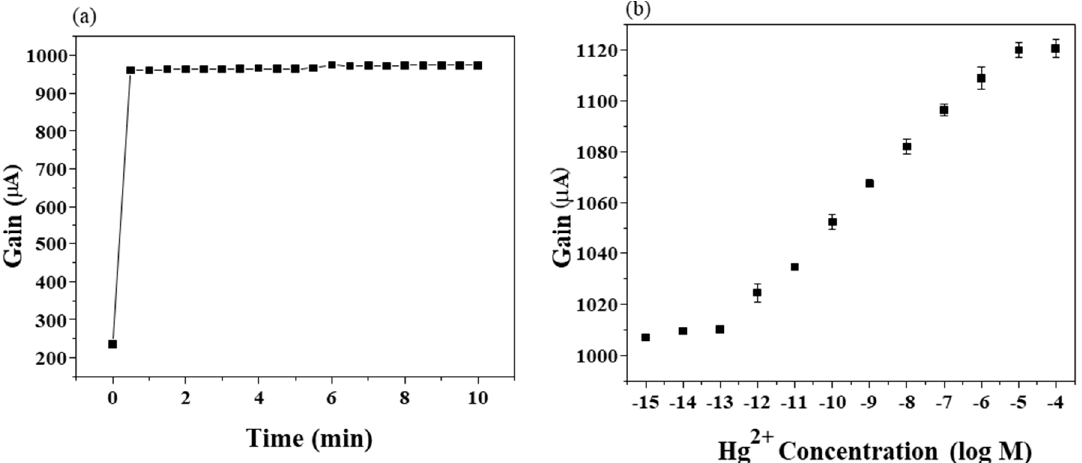
Figure 3. Sensor response; ( a ) Current gain response of extended gate Hg-ISMFET through time. ( b ) Current gain average verses different concentration of Hg 2+ prepared in 0.02X PBS by extended gate Hg-ISMFET (error bars obtained from multiple tests with n =